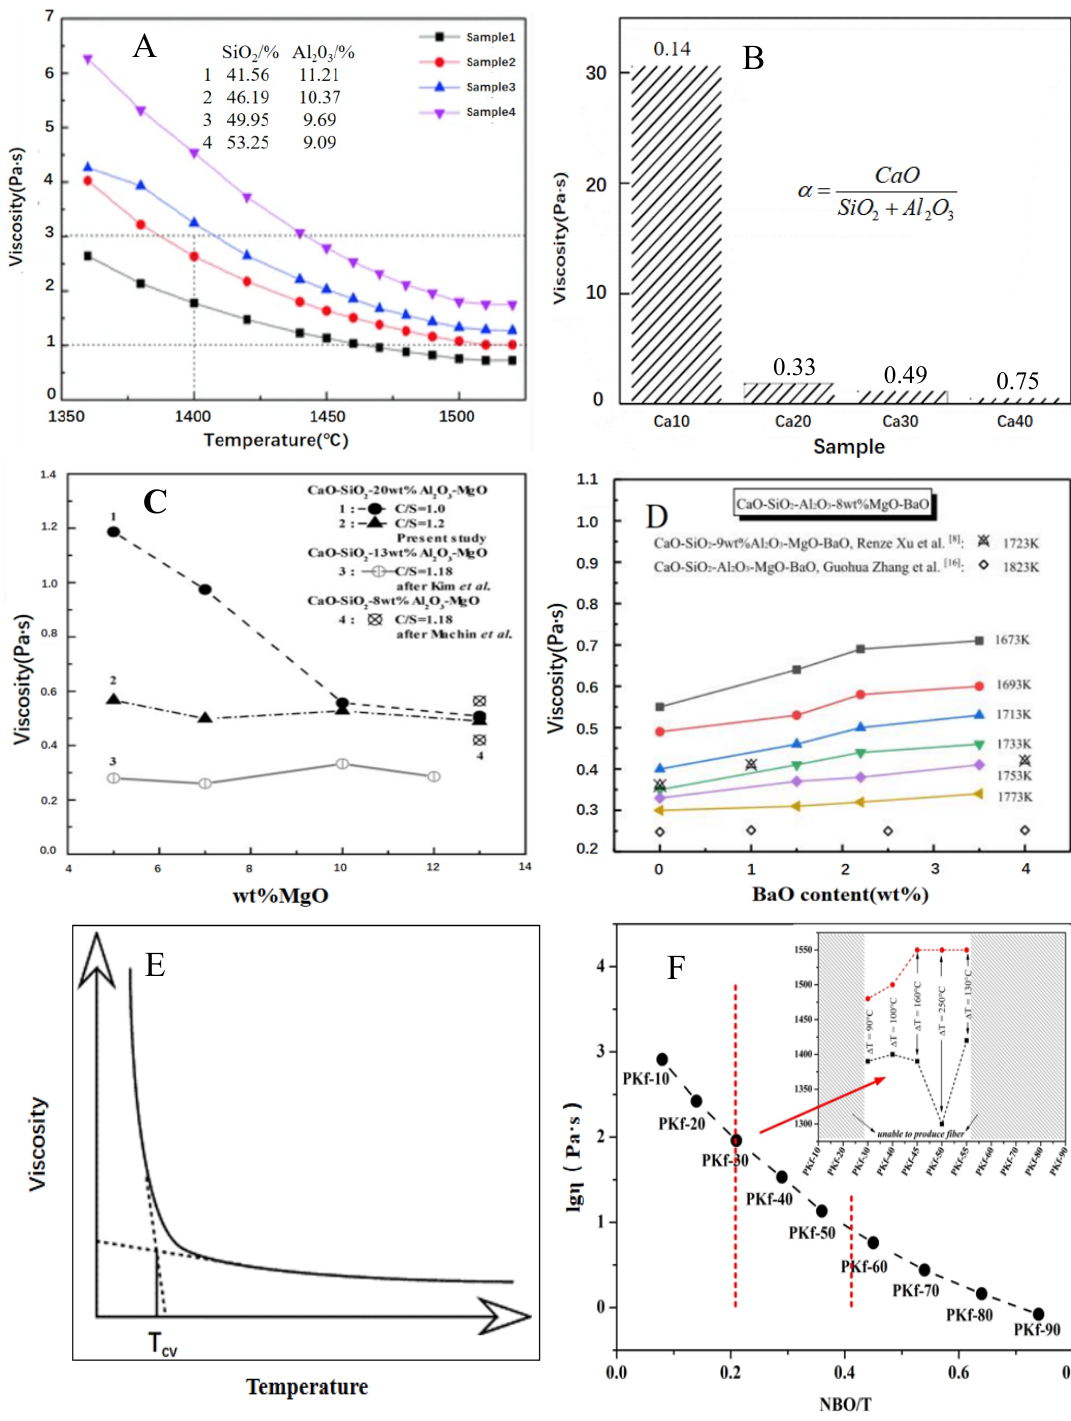
Figure 5. ( A ), Viscosity–temperature curves of melts with different SiO 2 and Al 2 O 3 content(Wu et al., 2020). ( B ) The viscosity of liquid phase of synthetic ash at 1350 °C with different α value (CaO/(SiO 2 + Al 2 O 3 ) mass ratio) (He et al., 2019). ( C ) Effect of MgO content on the viscosity of molten slag (Kim et al., 2010). ( D ) Effect of BaO content on the viscosity of molten slag (Zhang et al., 2013). ( E ) Illustration of the concept of T cv or temperature of critical viscosity (Vargas et al., 2001). ( F ) Plots between the viscosity and depolymerization degree of the melts with proper fiber-forming temperature range (Liu et al.,